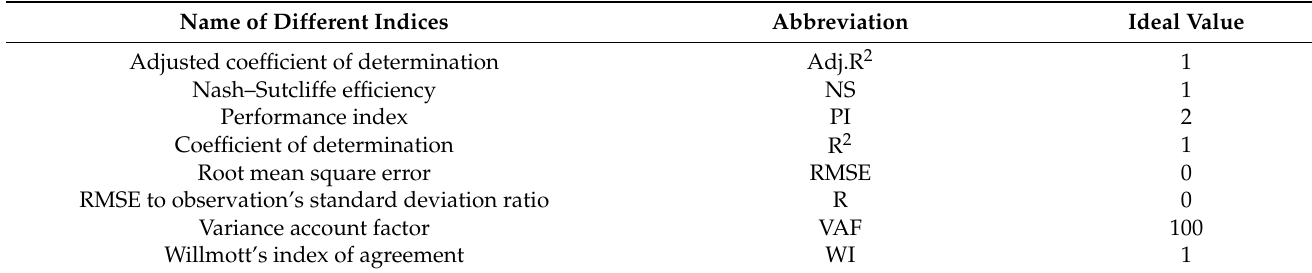
Table 4. Ideal values of different